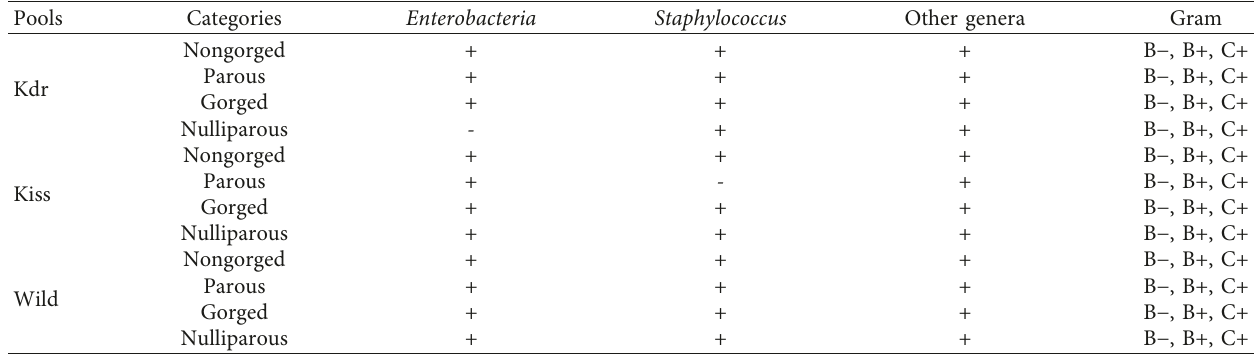
Table 5: Microbiological diversity of the microbiota according to batches of mosquitoes.